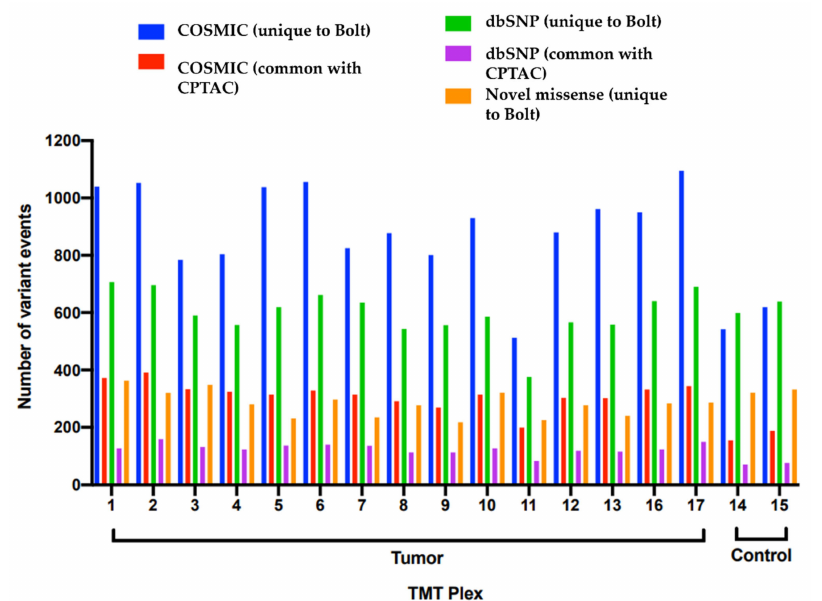
Figure 4. Mutation load of various TMT plexes for the different categories of variant events.